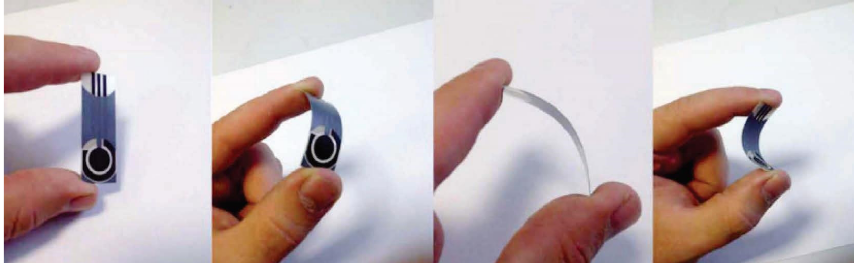
Figure 4: Cobalt hydroxide onto a plastic substrate by using a screen printing technique [119].